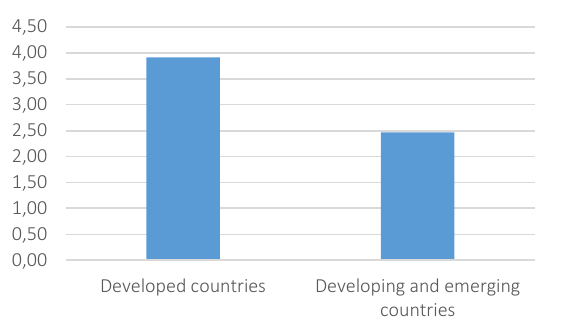
Figure B4. Non-government corporate